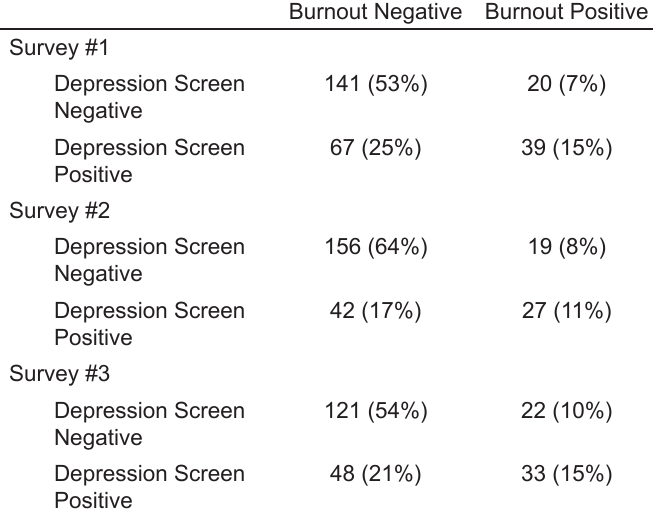
Table 4. Global burnout and depression screens.